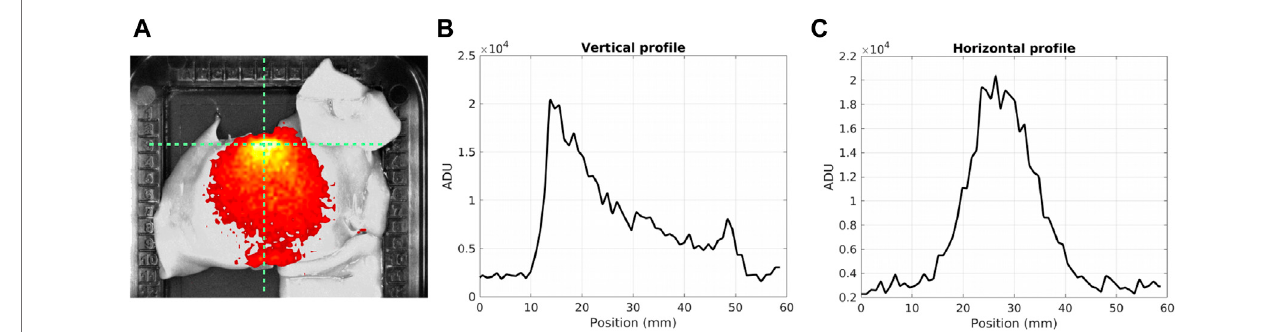
FIGURE2|(A) ExampleimageofawedgeoflivertissueoveraPetridish fi lledwith370 kBqof 68 Gain4 mlofwater.Theslabthicknessincreasesverticallyfrom2.5 to 7 mm. (B – C) Vertical and horizontal pro fi les corresponding to the dashed lines in the